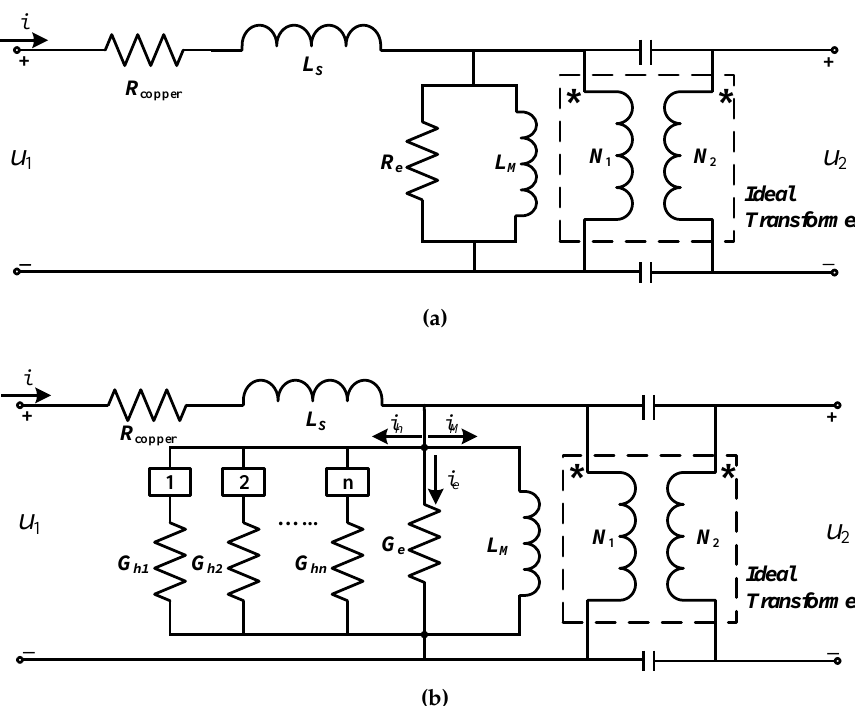
Figure 2. Equivalent circuits for the experimental specimen. ( a ) Linear transformer model; ( b ) Nonlinear model.